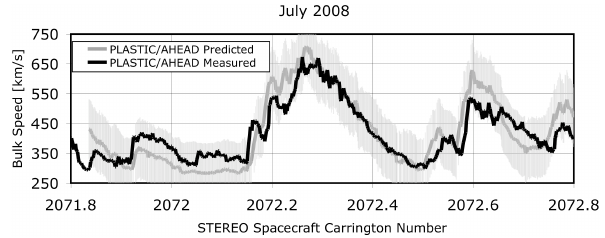
Fig. 6. Predicted and observed proton density at PLASTIC/AHEAD for July 2008. The uncertainty on the predicted density is shown with grey shading. The solid black curve shows the measured val-